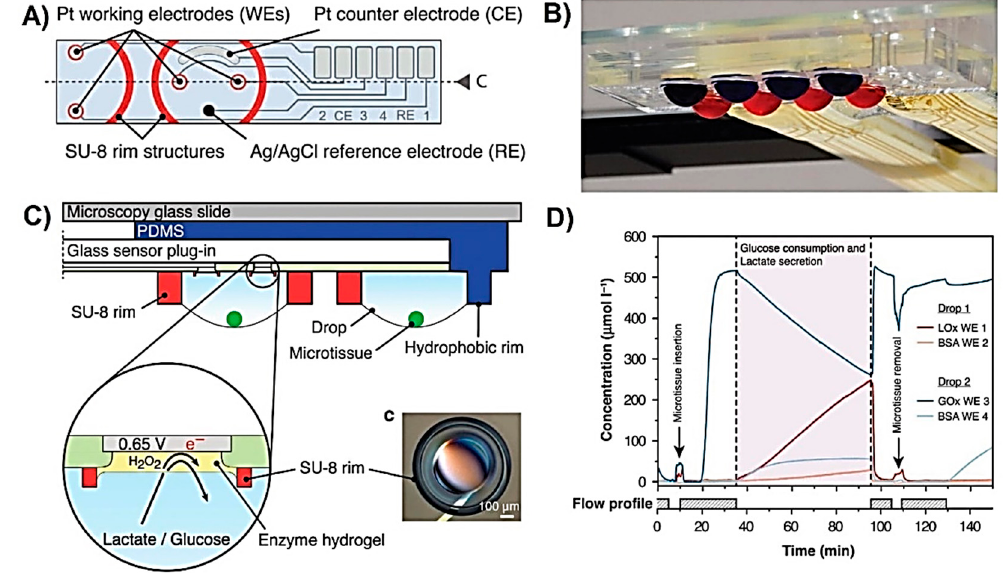
Figure 4. ( A ) Close-up view of the sensor unit featuring working, counter, and reference electrodes with the SU-8 rim structures indicated in red. ( B ) Photograph of an assembled device loaded with coloured liquid. ( C ) Configuration of the biosensor. ( D ) Monitoring the metabolism of HCT116 eGFP microtissues and their response to medium changes in terms of continuous measurements of glucose consumption and lactate secretion, reprinted from [100], copyright (2016) Springer Nature.